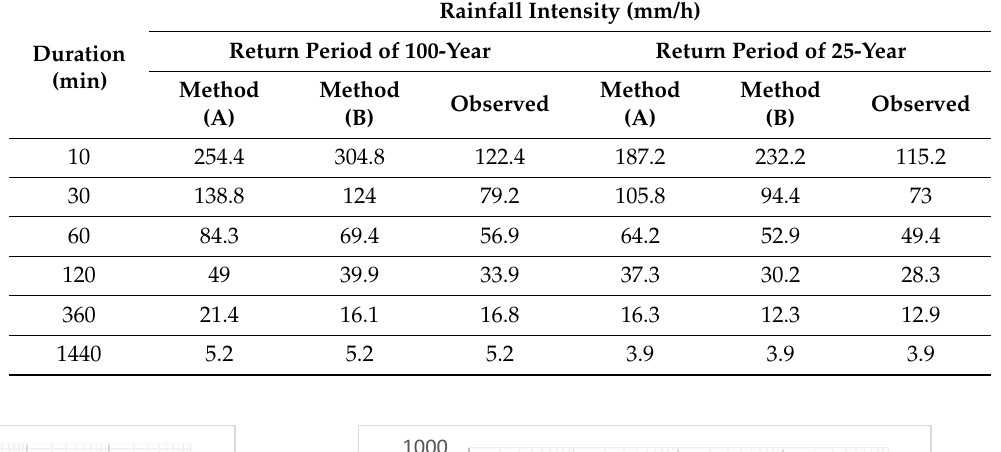
Table 6. The rainfall intensity of 100- and 25-year return periods using Log-Pearson type III distribution.